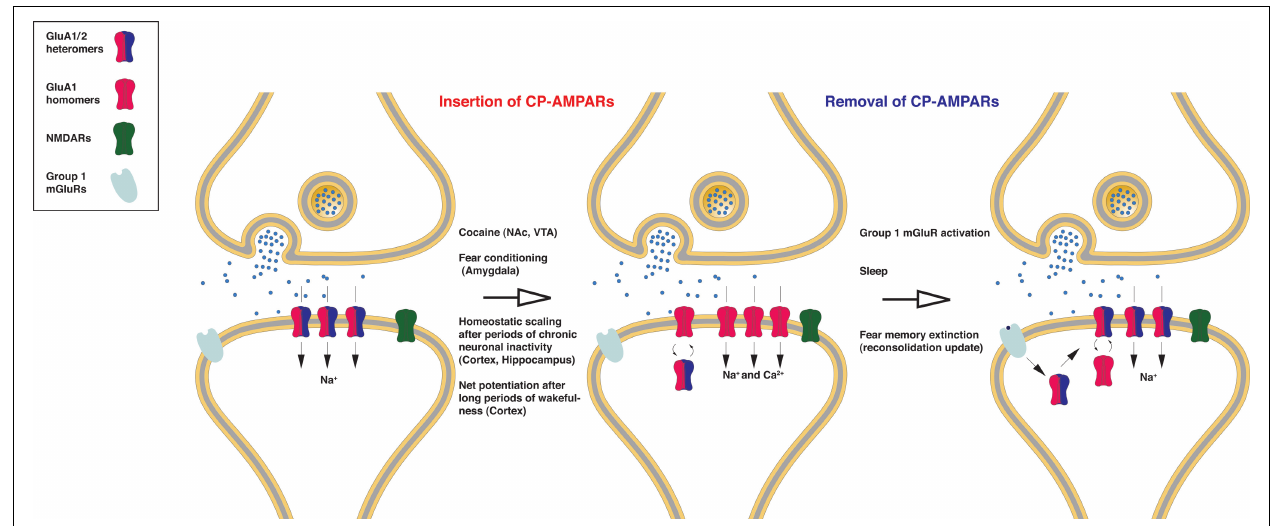
would also cause net potentiation of synaptic transmission. Although the time-course of induction may differ, cocaine injection; fear conditioning; homeostatic scaling; and long periods of wakefulness all result in an increase in synaptic/surface CP-AMPARs, which usually results in potentiation of synaptic transmission. In many cases CP-AMPAR surface/synaptic expression is transient but removal of CP-AMPARs can be facilitated by the activation of group 1 mGluR activation, perhaps by synthesizing GluA2 subunits locally at synapses, which also results in mGluR-dependent synaptic